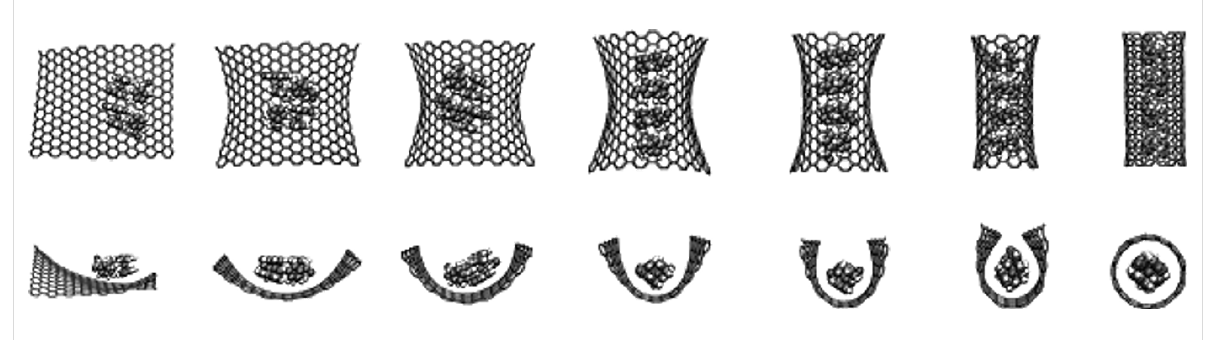
Figure 4: Slow-motion roll up of a graphene layer. Fc–CHO molecules template the rolling of the graphene sheet. Reprinted with permission from [31], copyright 2013 Wiley-VCH.